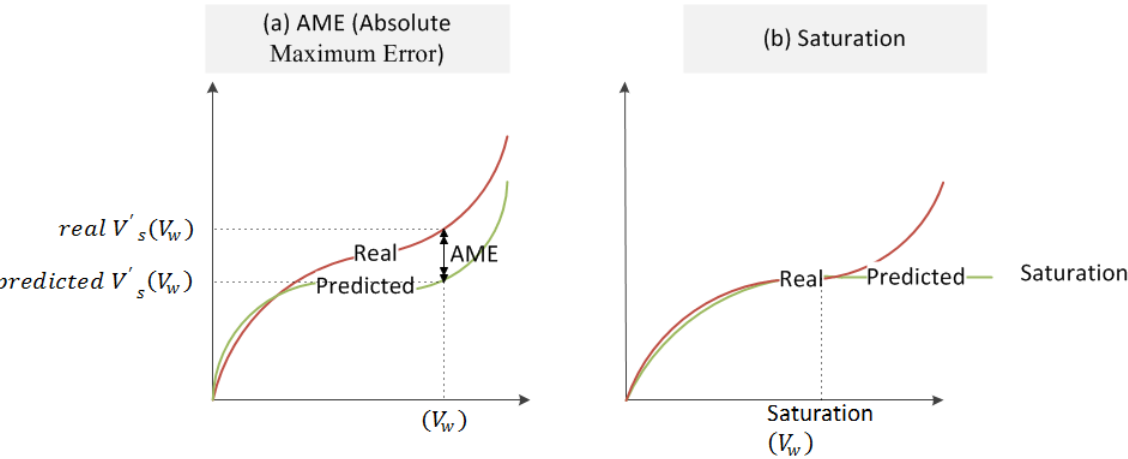
Figure 4. Ad hoc indicators ( a ) AME; ( b )